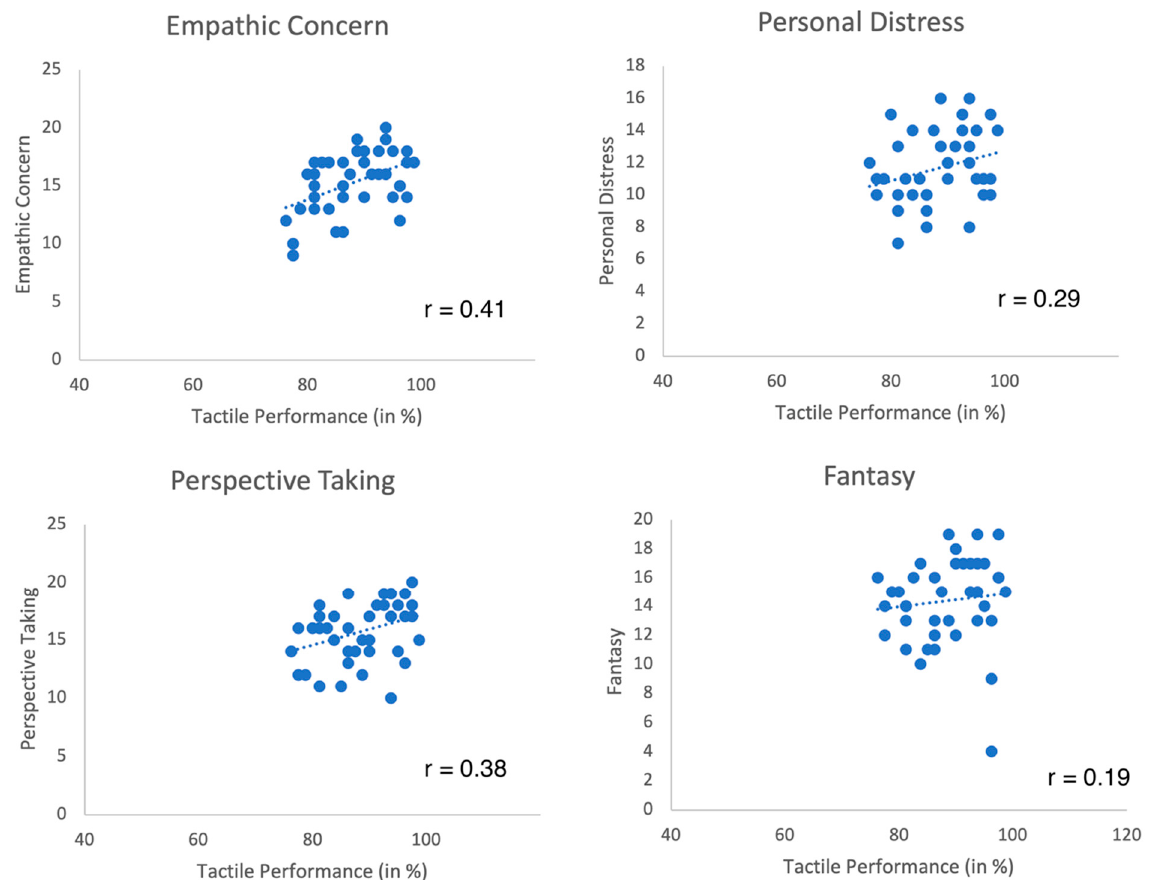
Figure 1. Scatterplots of tactile performance and empathy subscales (Pearson correlations). Empathy was linearly associated with tactile acuity (correlation coefficients of Fantasy raised to r = 0.37 when removing two outliers). SPS was not related to performance in the tactile task (see Table 2 for details). Table 1. Results of personality questionnaires SPS, IRI, and BFI. (1 − beta error probability) of 0.98 (alpha = 0.05).